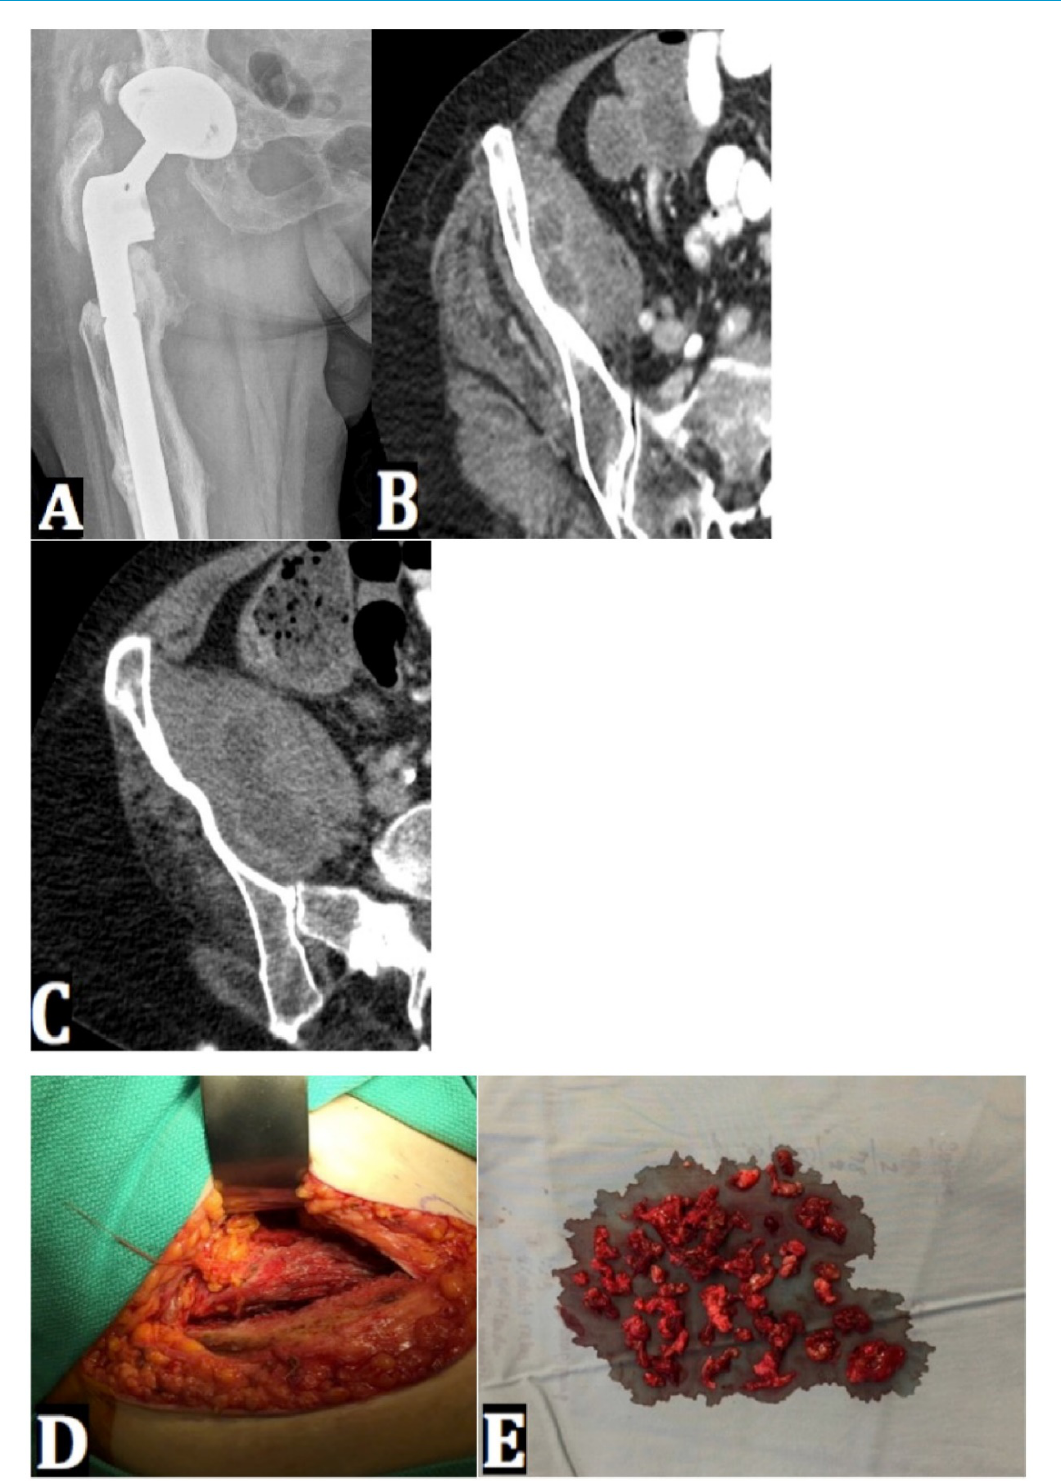
Figure 4. (A) An AP radiograph of the right hip shows a revision hip prosthesis with minimal femoral bone stock and lucency surrounding the femoral stem. The component position has not changed over a ten-year period. (B) An axial CT right hip image shows new enlargement of right iliacus muscle containing multi-loculated fluid collection. (C) A repeat axial CT right hip image of the right hip shows an interval increase in size of the collection in the right iliacus muscle. (D) An intraoperative photo of the retroperitoneal approach to the inner table of pelvis shows the point of access to the proximal belly of the iliacus muscle. (E) An intraoperative photo shows debrided iliacus muscle abscess